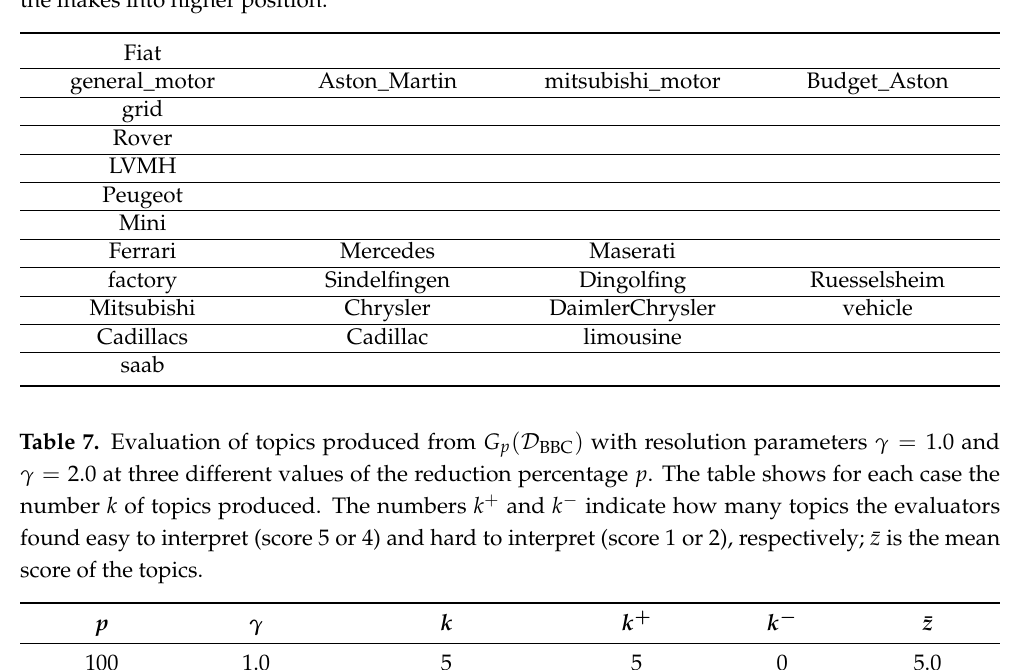
Table 6. Beginning of the stratified topic sheet for one of the 89 topics at γ = 2.5 which can be interpreted as Automotive. The terms in this clipping are dominated by car makes (LVMH being an outlier, though one can imagine why it is included in the same cluster). While lower parts of the sheet not visible here also contain general terms from the subject field, such as “motorsport”, “sportscar”, “racing”, “braking”, “steering”, “throttle”, and “gearbox”, the specificity ranking puts the makes into higher position.